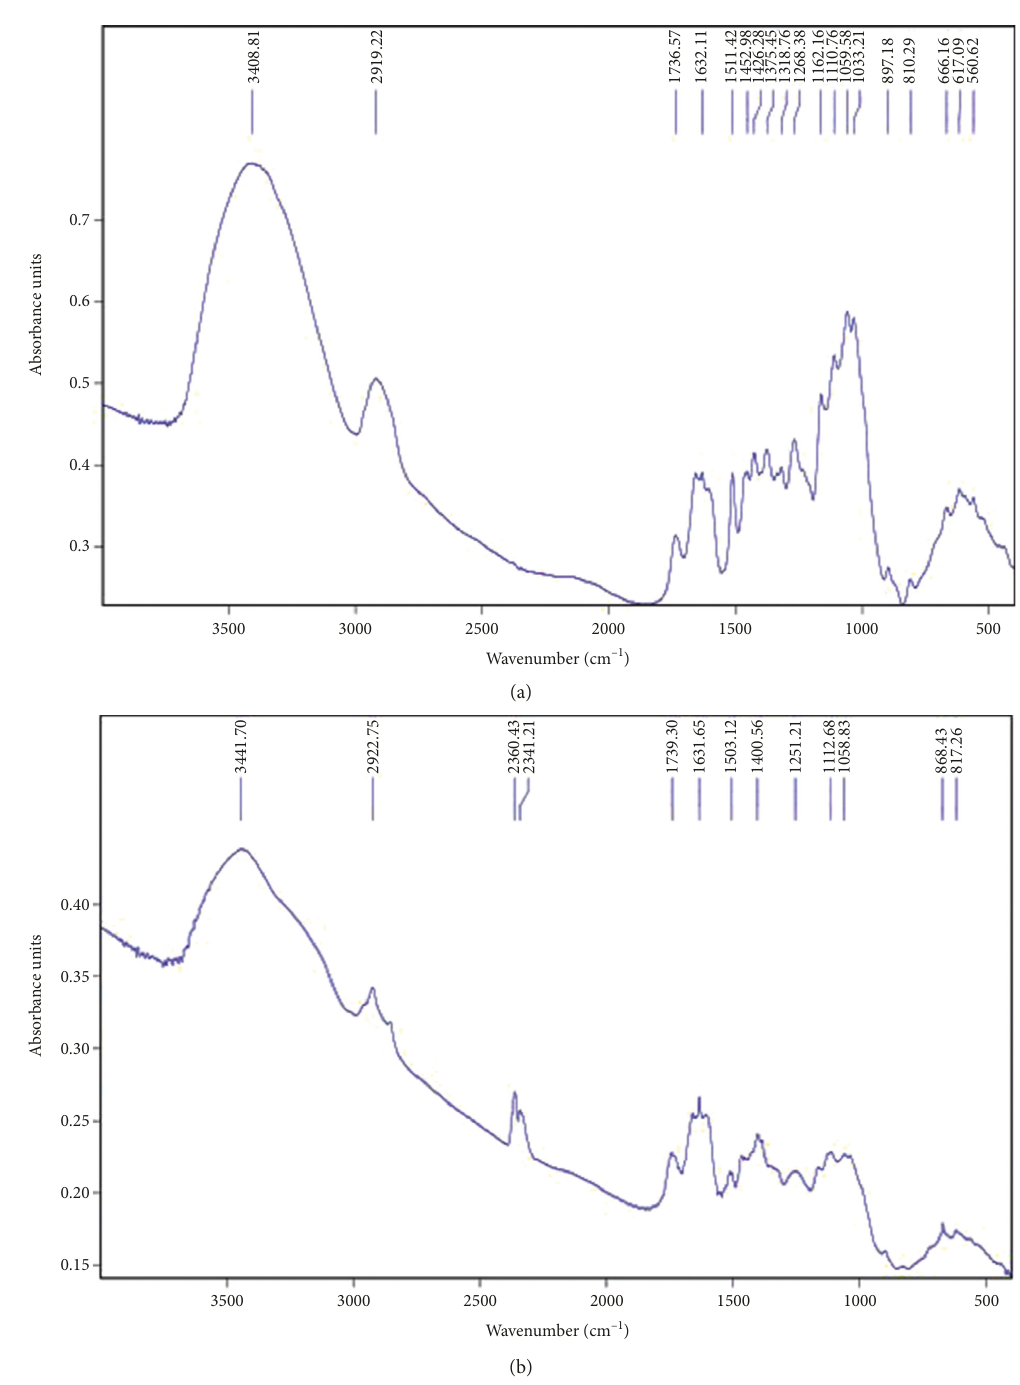
Figure 2: (a) Infrared spectrum of the RS; (b) infrared spectrum of the